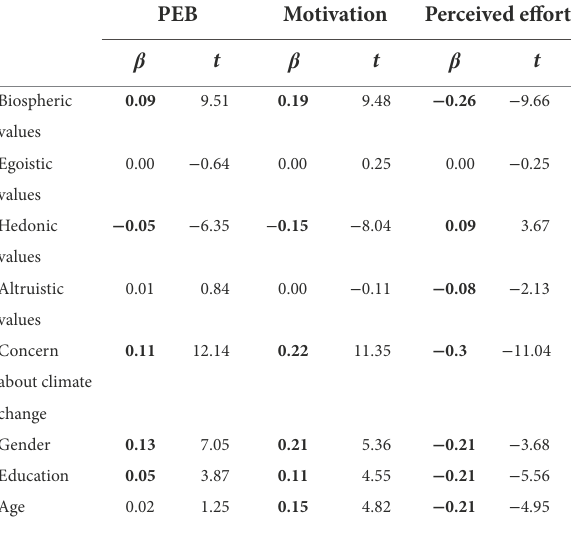
TABLE 4 Total effects (coefficients and t -values) of predictors ( x ) on PEB, motivation and perceived effort of model 4. PEB